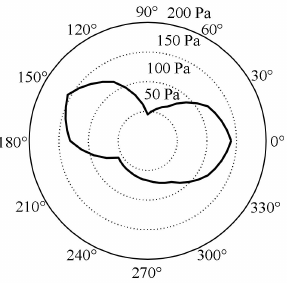
Figure 9. The distributions of the acoustic pressure amplitude in the polar coordinate system for the load of 4500 N.